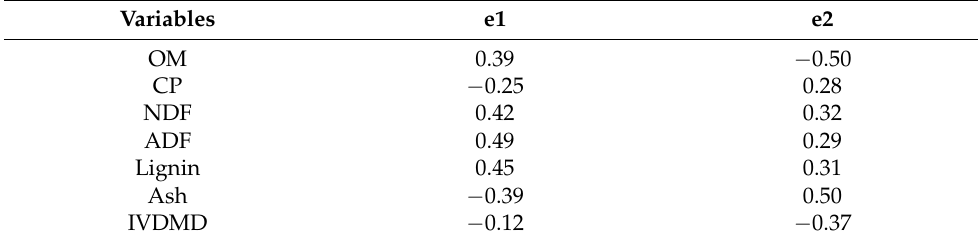
Table 6. PCA eigenvectors obtained with the nutritional quality data of the evaluated plants.